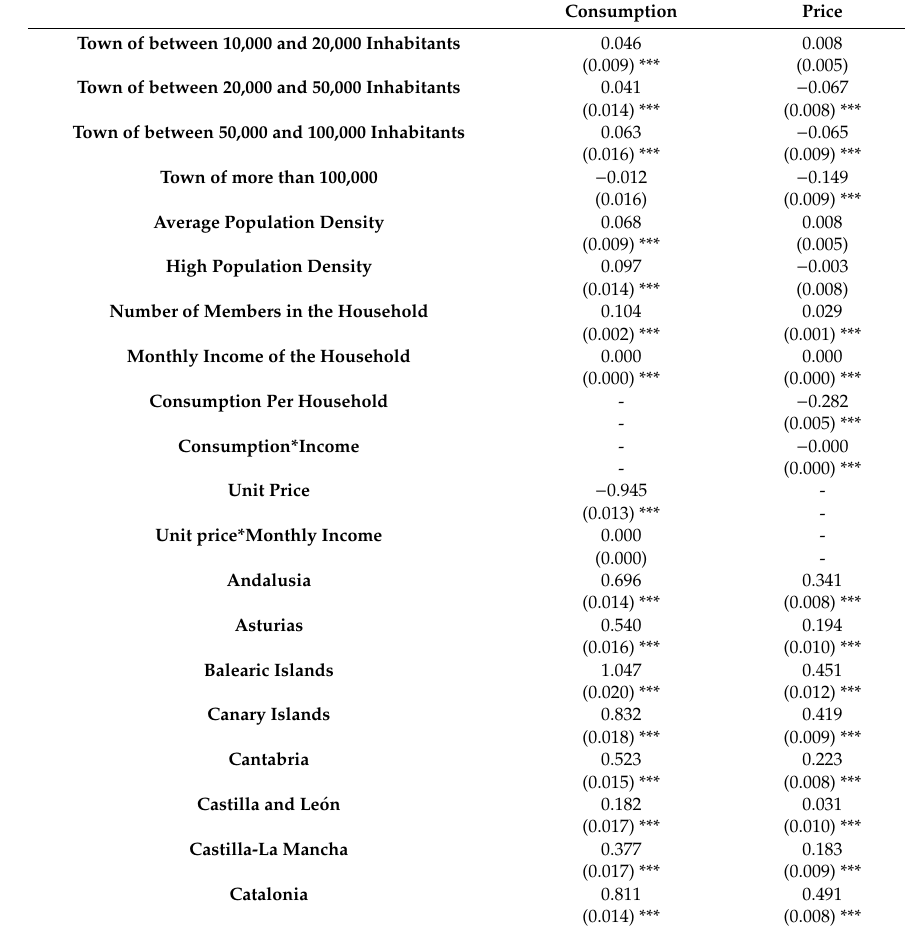
Table 5. Estimation of Models (1) and (2) with National